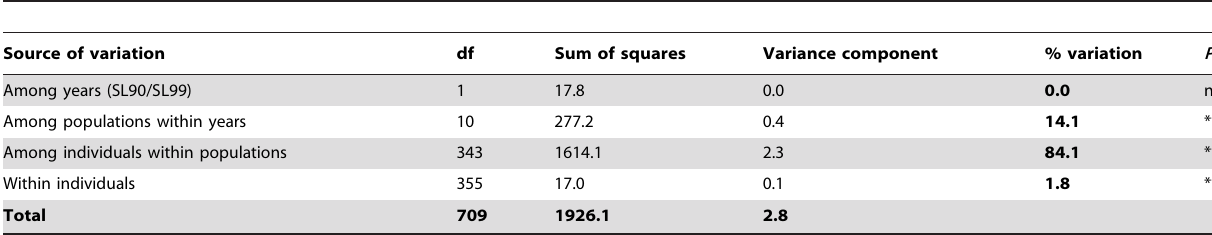
Table 4. Analysis of the molecular variance using SSR markers, performed at different levels.